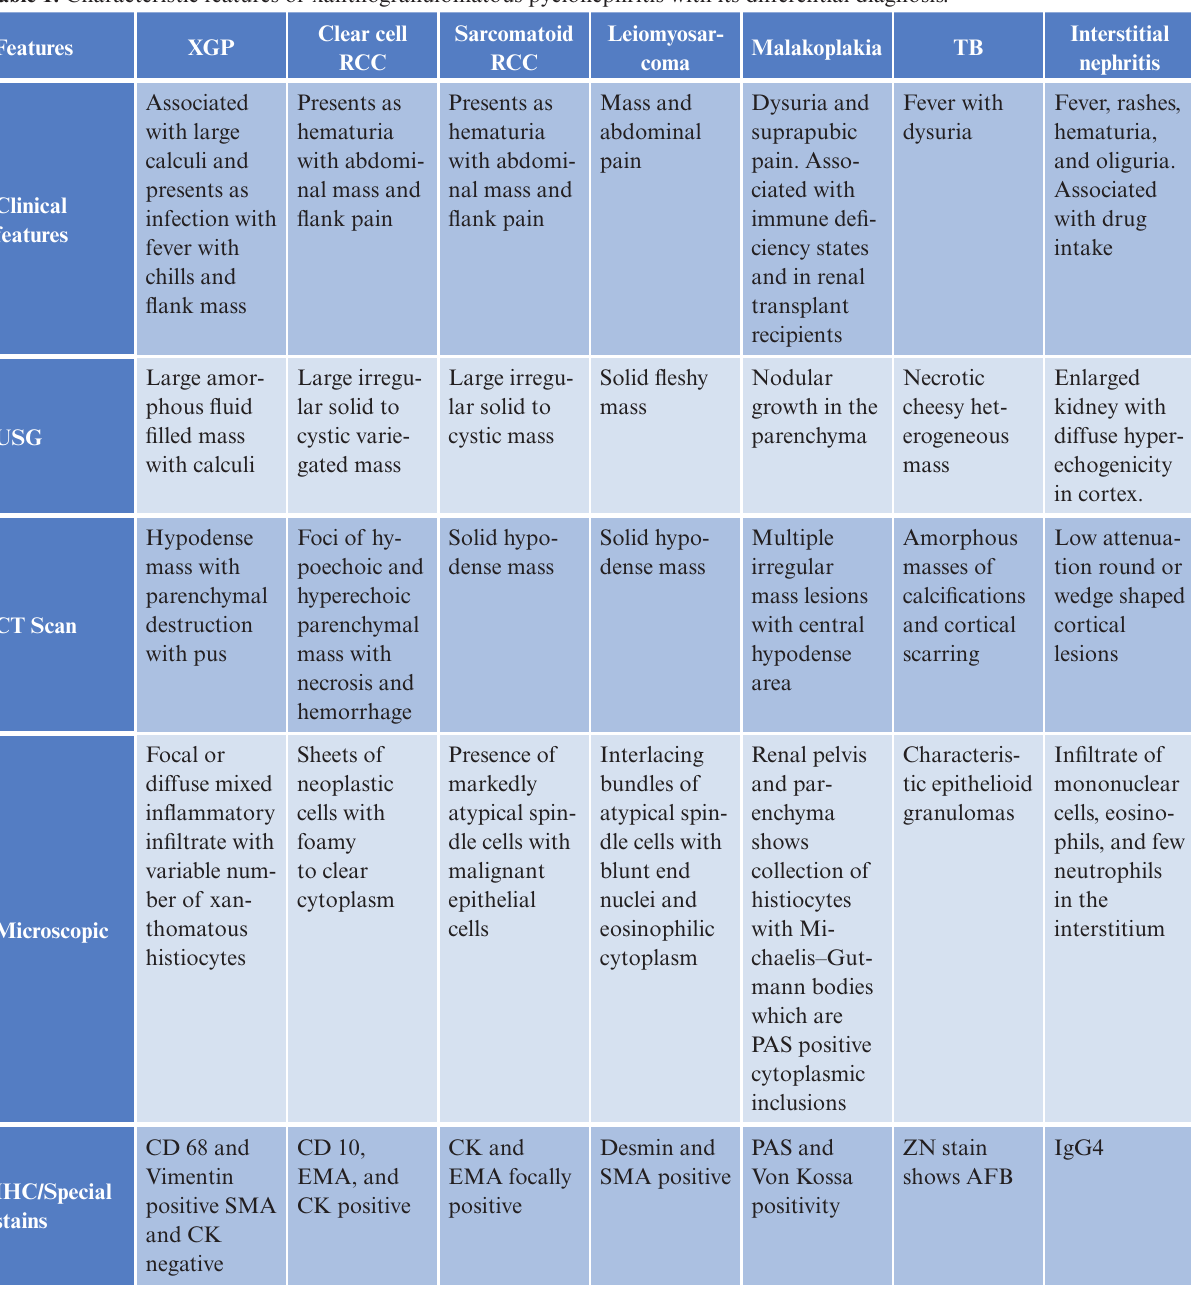
Table 1. Characteristic features of xanthogranulomatous pyelonephritis with its differential diagnosis.